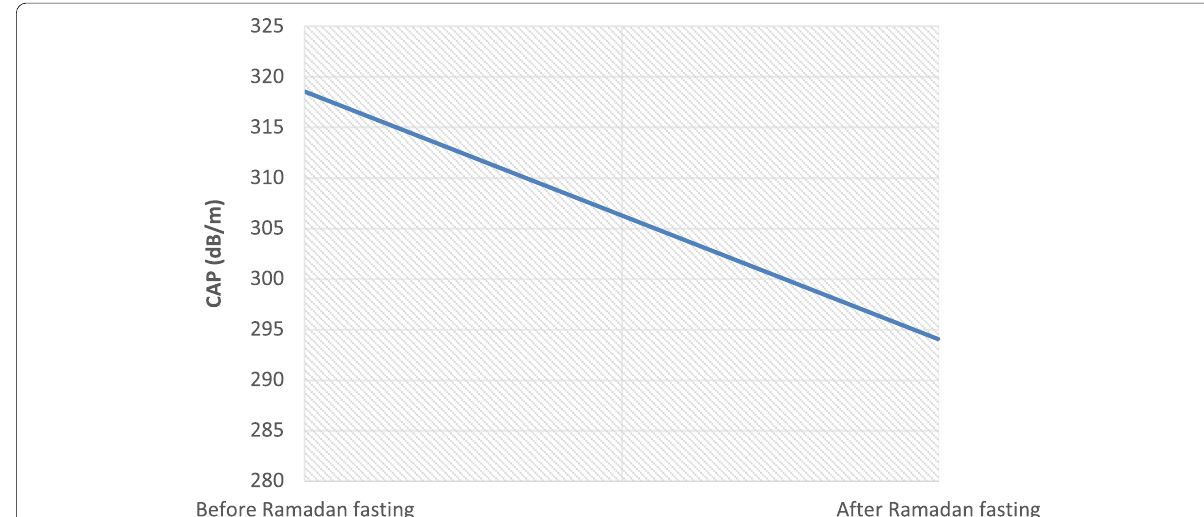
Fig. 1 Line graph showing the CAP results before and after Ramadan fasting in the study group